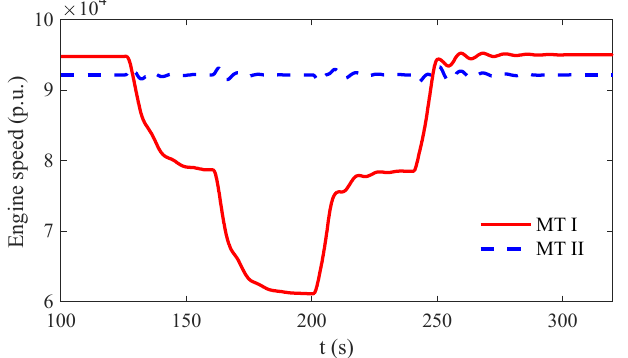
Figure 9. Variations of engine speed during the MT output adjustment process.